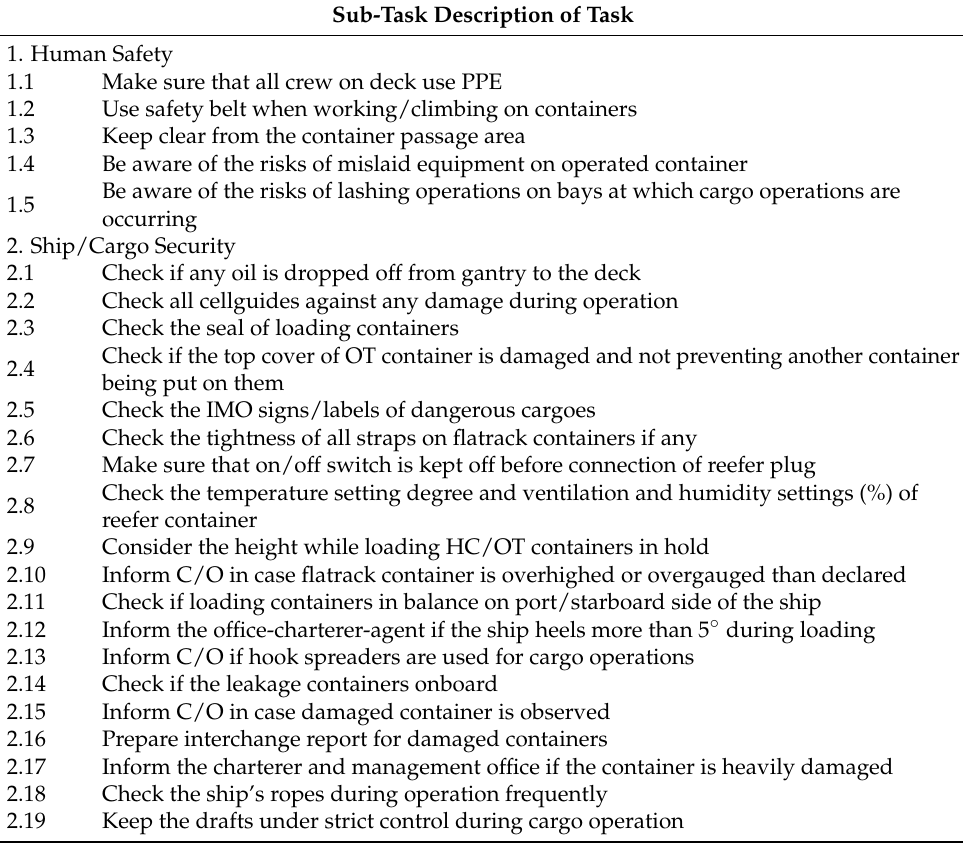
Table 1. Task description of a cargo-loading operation.